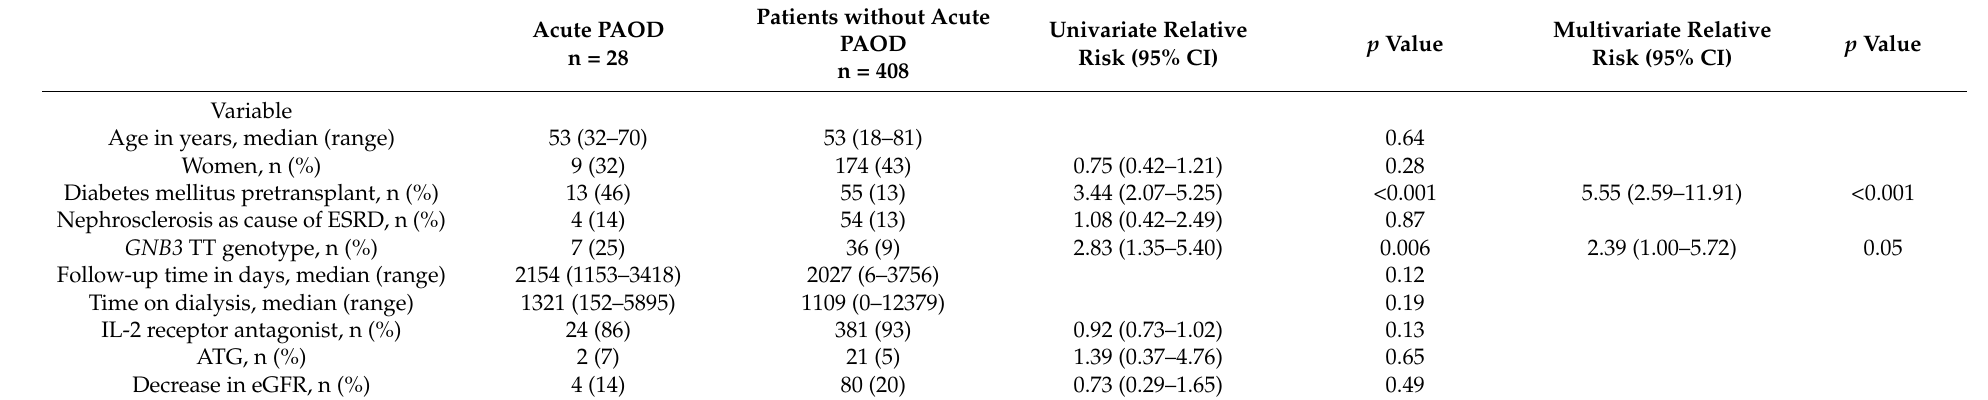
Table 4. Results of univariate and multivariate analyses identifying risk factors for the development of acute peripheral artery occlusive disease among 436 patients after renal allograft